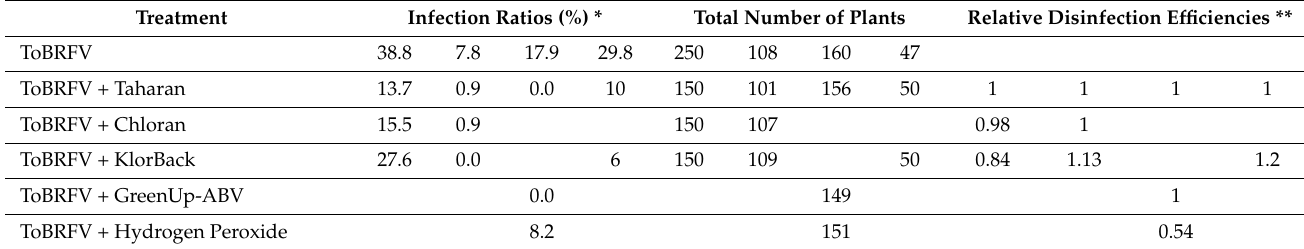
Table 1. Relative disinfection efficiencies of ToBRFV infested sandy soil.